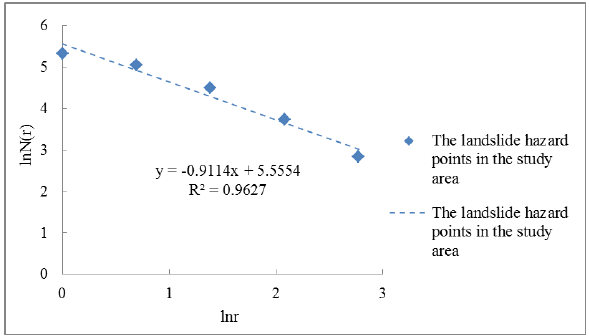
Figure 2. Fitting straight line of lnr-lnN(r) of landslide hazard points in Dachuan District